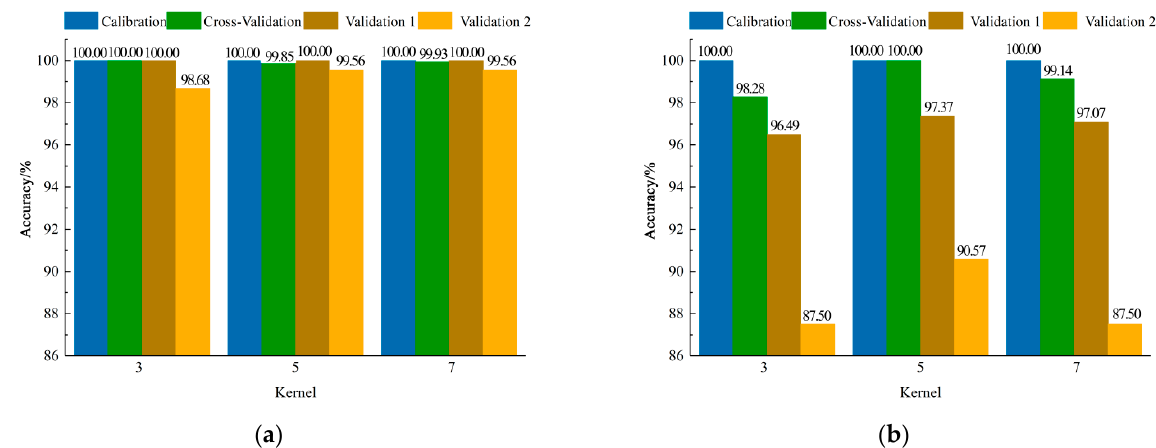
( b ) Figure 7. Results of CNN-SVM models with different convolution kernel sizes based on mean